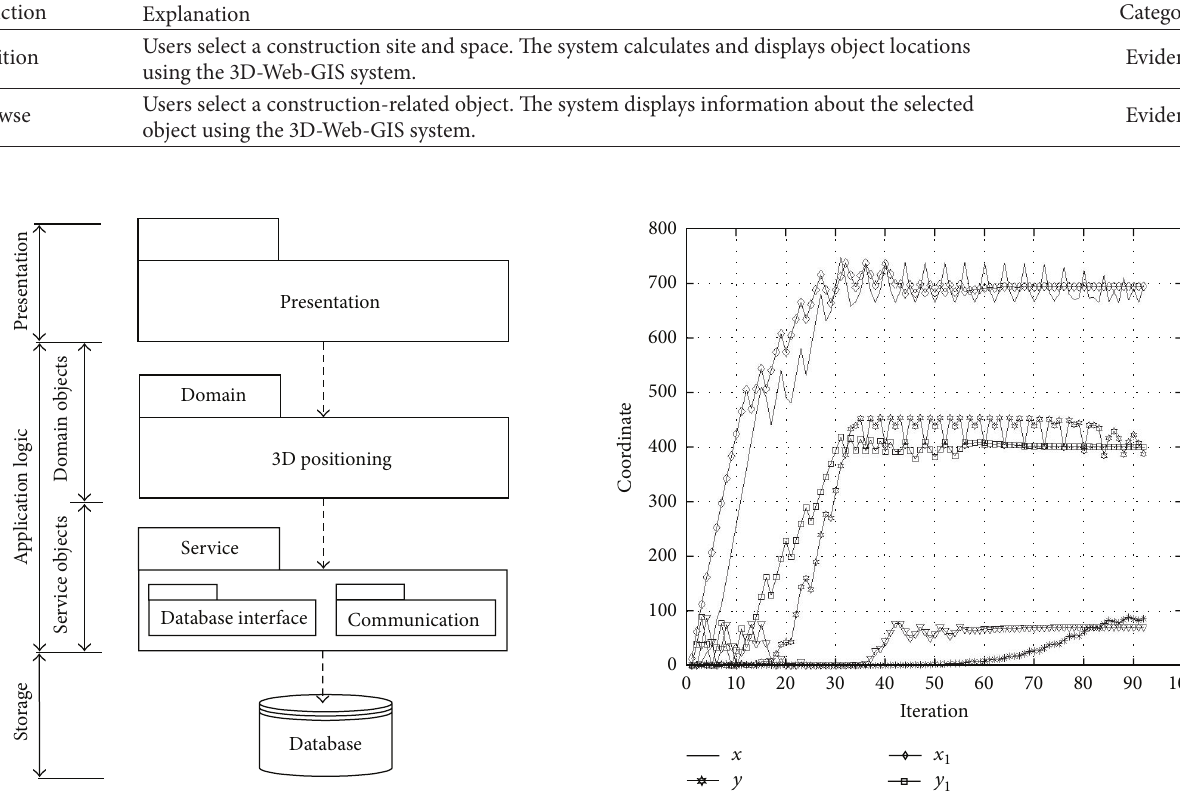
Figure 8: System architecture.